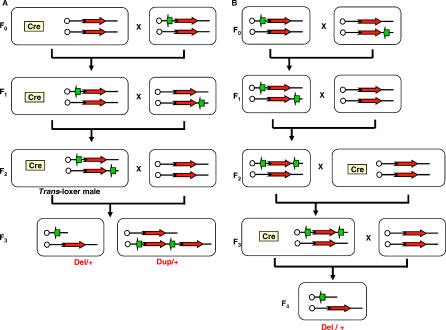
Strategies for In Vivo Cre-Mediated Recombination(A) The general principle of TAMERE is based on two successive breedings in order to have in one male, named the trans-loxer, the Sycp1Cre (Synaptonemal Complex protein 1) transgene and the two loxP sites in a trans configuration, inserted previously in the same orientation at each targeted locus, that define the genetic interval. The Synaptonemal Complex protein 1 promoter drives Cre expression at prophase of meiosis in male spermatocytes when chromatid pairs are closely aligned, in order to facilitate the chromatid exchange, leading to the formation of the deletion and the duplication of the interval delimited by the two loxP sites. The last step consists in mating trans-loxer males with wild-type females to generate, in the progeny, individuals carrying the deletion or the duplication of the targeted region.(B) The STRING approach takes advantage of a classical crossing-over to bring the two loxP sites into a cis configuration to generate a deletion. Two parental mice (F0) carrying loxP sites flanking a selected region are crossed. The F1 progeny containing the two loxP sites are then mated to wild-type mice. The offspring are screened for meiotic crossing-over between both sites leading to mice carrying the loxP sites in a cis configuration. In the subsequent cross, a ubiquitously expressed Cre transgene is introduced, generating the deletion that is established in the next F4 generation.Del, deletion; Dup, duplication.red arrow, region of interest; green arrow, loxP site.